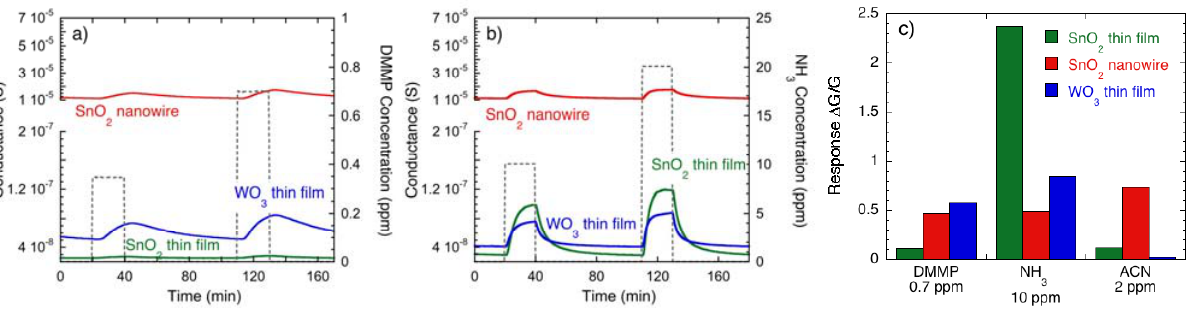
Figure 8. Dynamic response of sensors based on SnO and WO thin film to ( a ) DMMP (simulant for Sarin nerve agent) and ( b ) ammonia. 3 ( c ) Comparison between the response of sensors based on SnO